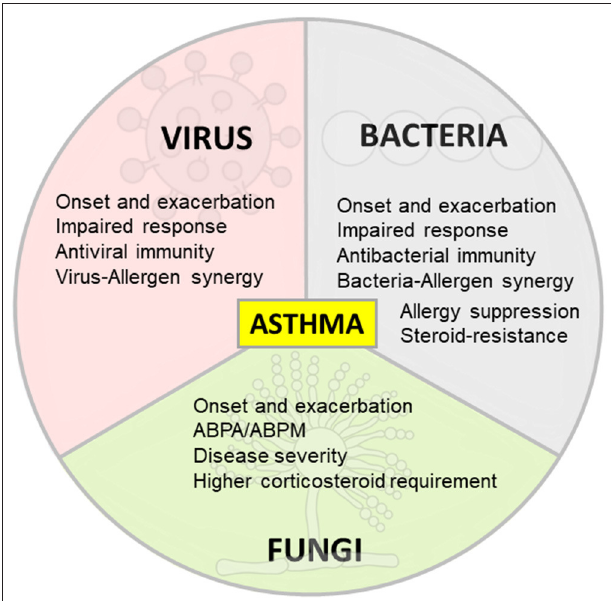
FIGURE 1 | Differing effects of respiratory infections on asthma. Viral, bacterial and fungal respiratory infections are associated with asthma onset and exacerbation. The immune response in allergic asthma is defective against respiratory viruses and bacteria in some scenarios and promote antiviral and antibacterial immunity in other contexts. Allergy and respiratory pathogens may also synergize to increase inflammation and damage in asthma. On the contrary, some bacteria are able to suppress allergic inflammation. Specific bacteria are linked to T2-low asthma, steroid resistance and immune response impairment. Fungal sensitization/infection in allergic asthma is associated with disease severity and higher corticosteroid